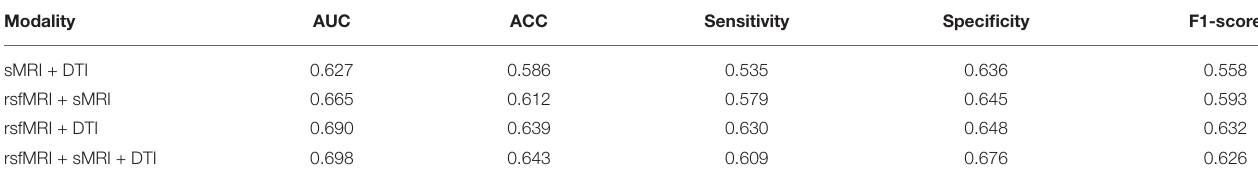
TABLE 4 | Performances of bimodal and trimodal multiple kernel learning (MKL) classification.